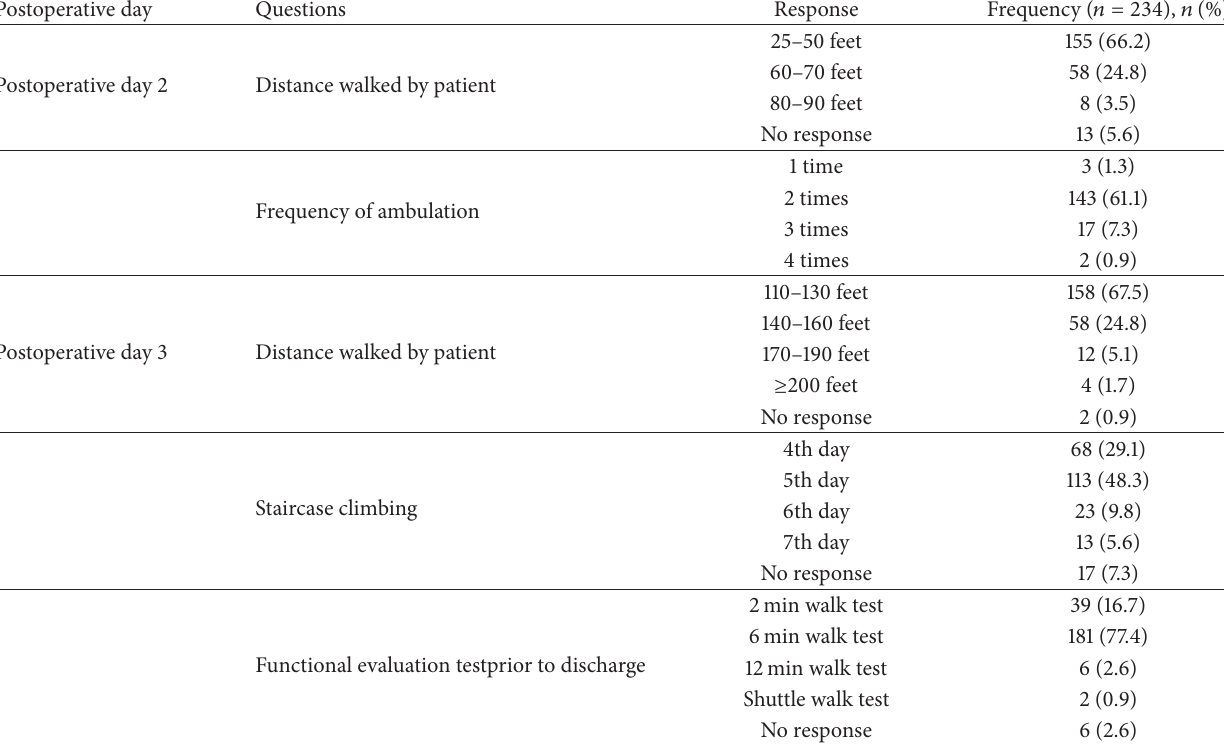
Table 8: The mobilization on various postoperative